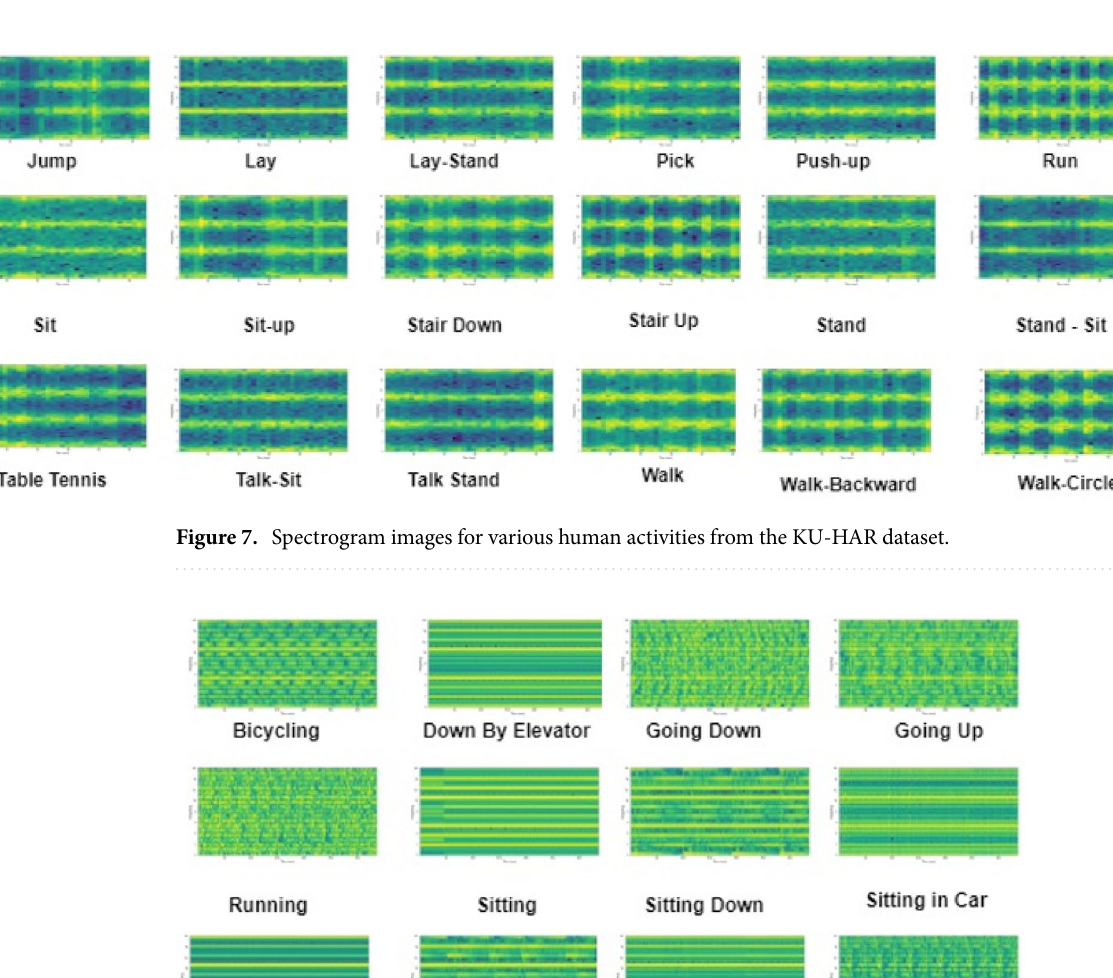
Figure 6. Spectrogram images for various human activities from the HARTH dataset.